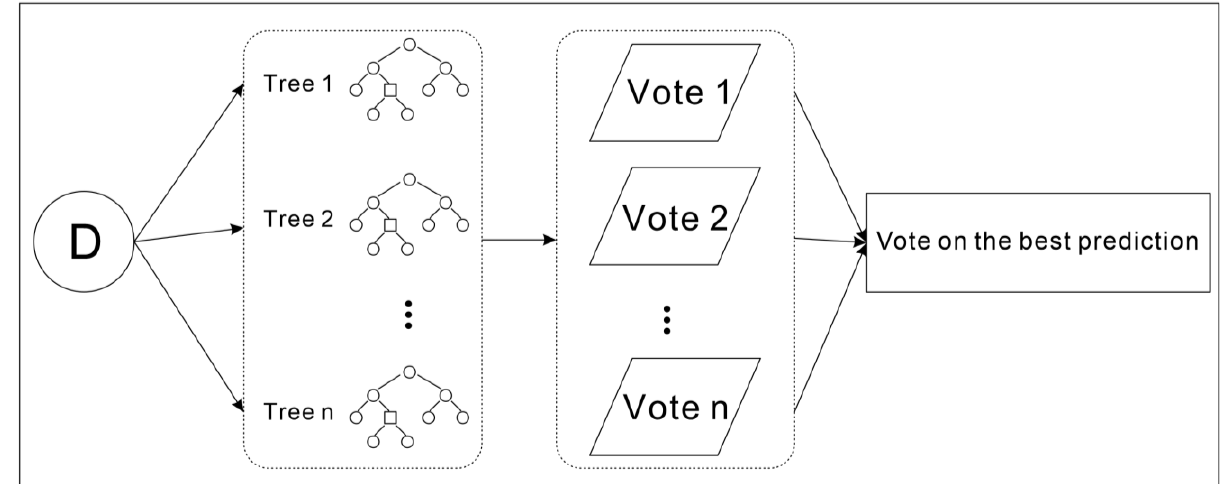
Figure 5. Conceptual flow of RF model. D is the training dataset.